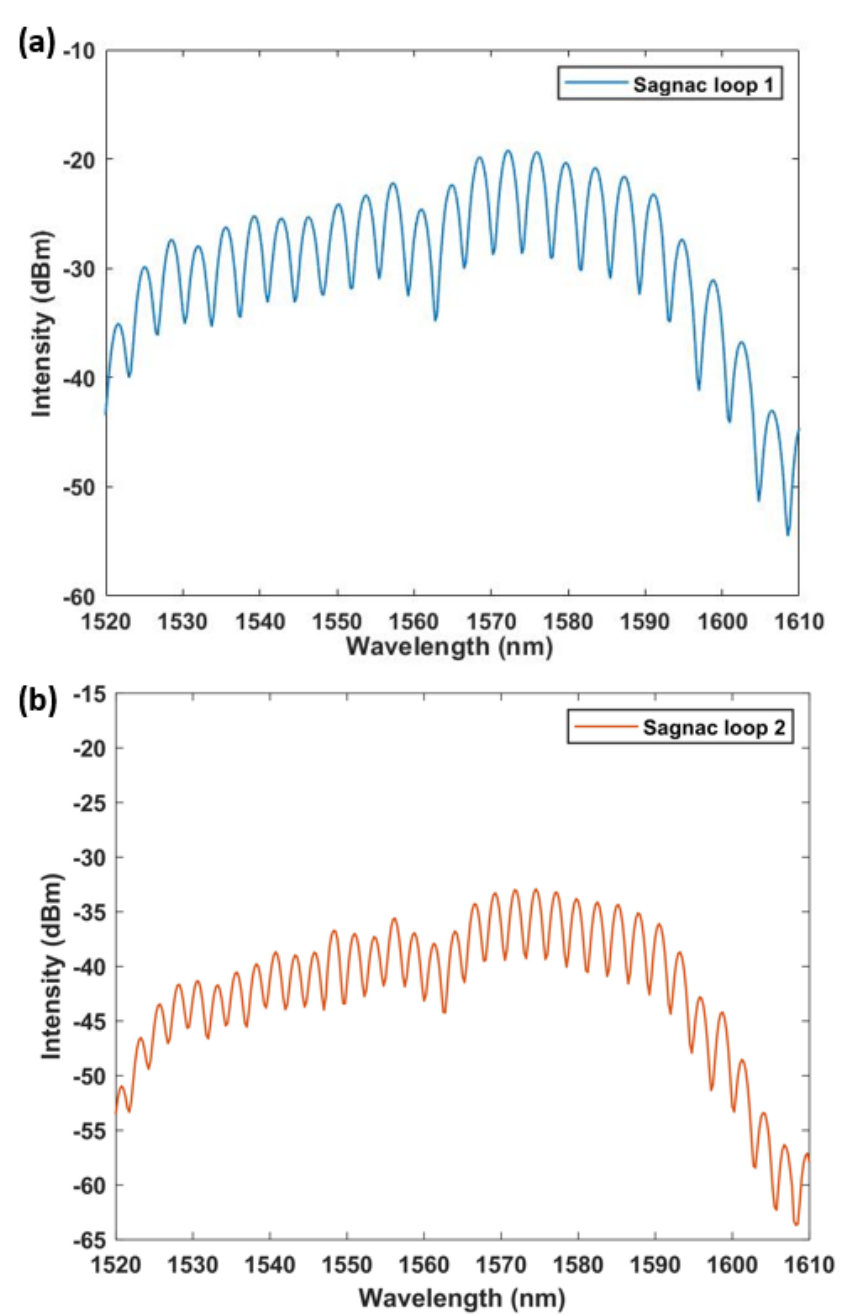
Figure 2. The output spectrum of different Sagnac rings with lengths of ( a ) loop 1 = 1.45 m, ( b ) loop 2 = 1.6